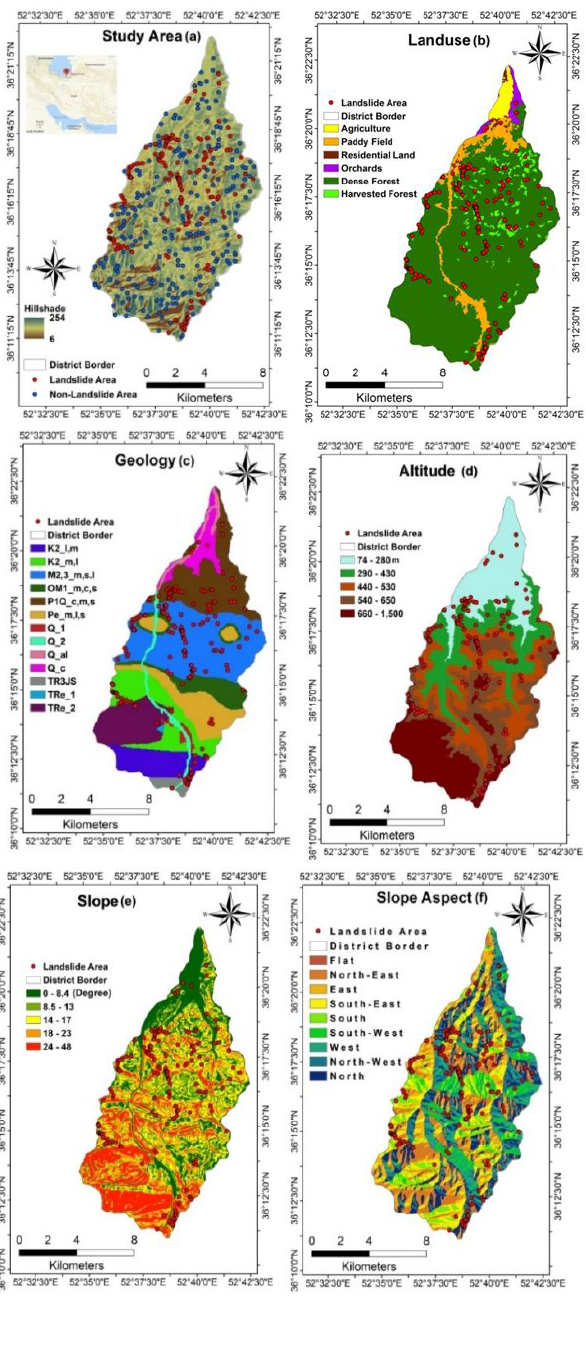
plane) that influences surface runoff characteristics. Total curvature is the surface’s curvature, which is by definition, equals to the sum of the profile and plan curvatures. Extra details regarding curvatures (which include equations and formulas), can be found in the literature (Alkhasawneh et al. 2013). In this work, total, profile, and plan curvature maps were classified into three categories: (i) concave, (ii) flat, and (iii) convex (Figure 1 l, m,